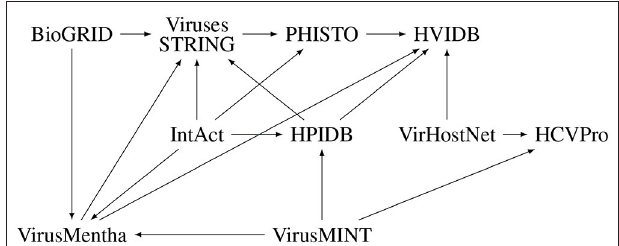
FIGURE 1 | Dependencies among virus-host protein–protein interaction databases.